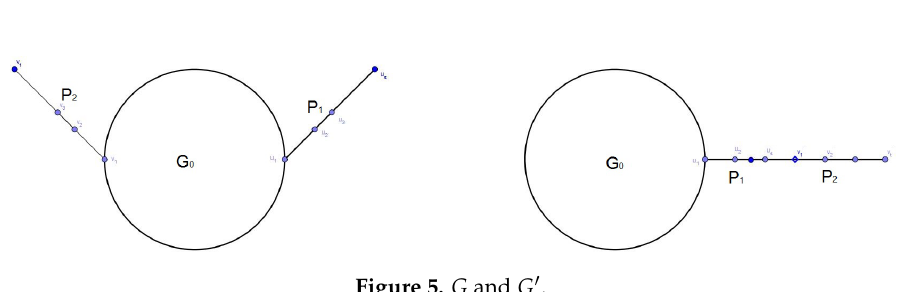
Figure 5. G and G (cid:48)